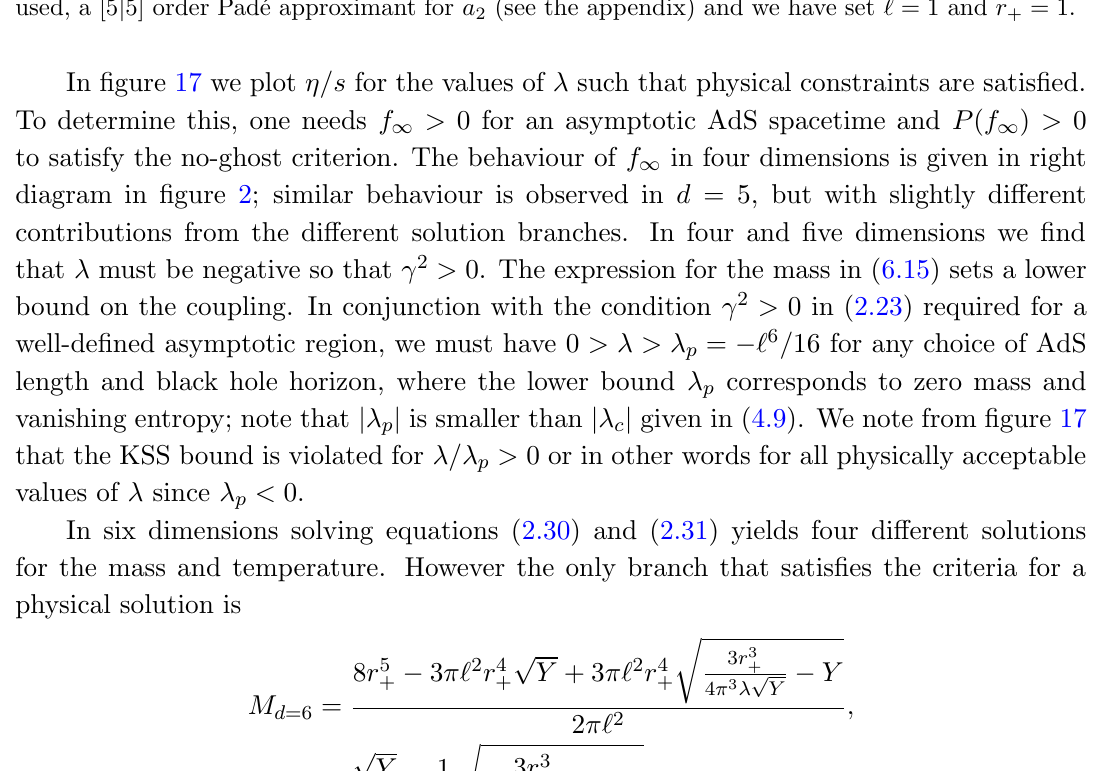
Figure 17 . Ratio of shear viscosity to entropy density . Left : plot of the ratio (cid:17)=s in four (blue) dimensions, (cid:12)ve (red) dimensions and six (black) dimensions. Right : a close up for small values of the coupling. The thin grey line shows the universal Einstein gravity value of (cid:17)=s = 1 = (4 (cid:25) ). we used, a [5 j 5] order Pad(cid:19)e approximant for a 2 (see the appendix) and we have set ‘ = 1 and r + =